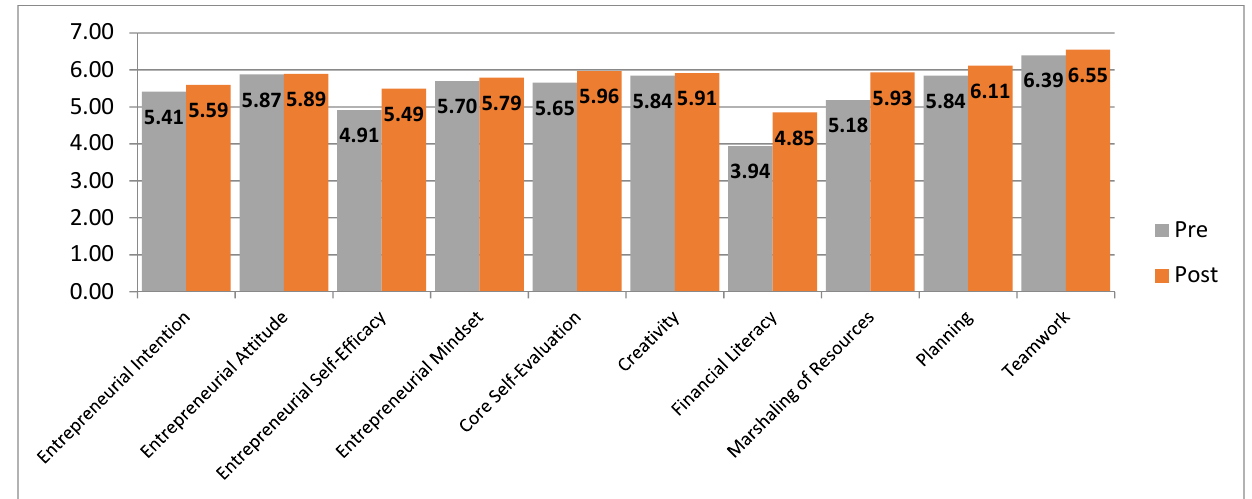
Figure 9. The average values of the entrepreneurial characteristics, pre- and post-course, of the students who worked on entrepreneurial ideas proposed by other students.